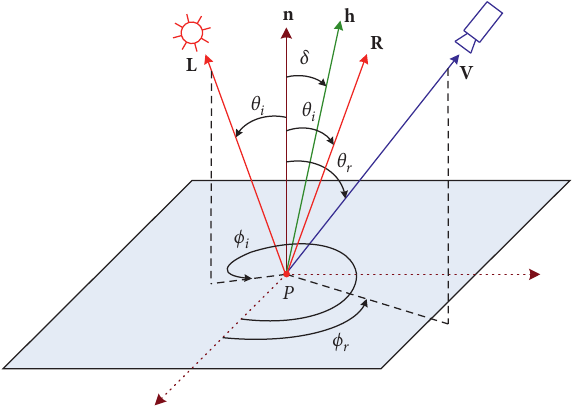
Figure 1: Reflection geometry of a local surface point. n is the unit normal of the surface point P ; ( θ r , ϕ r ) and ( θ i , ϕ i ) are the camera direction V and incident light direction L , respectively; R is re- flected light direction; h is the unit angular bisector of V and L ; that is, h � ( V + L ) / ‖ V + L ‖ ; δ is the angle between n and h